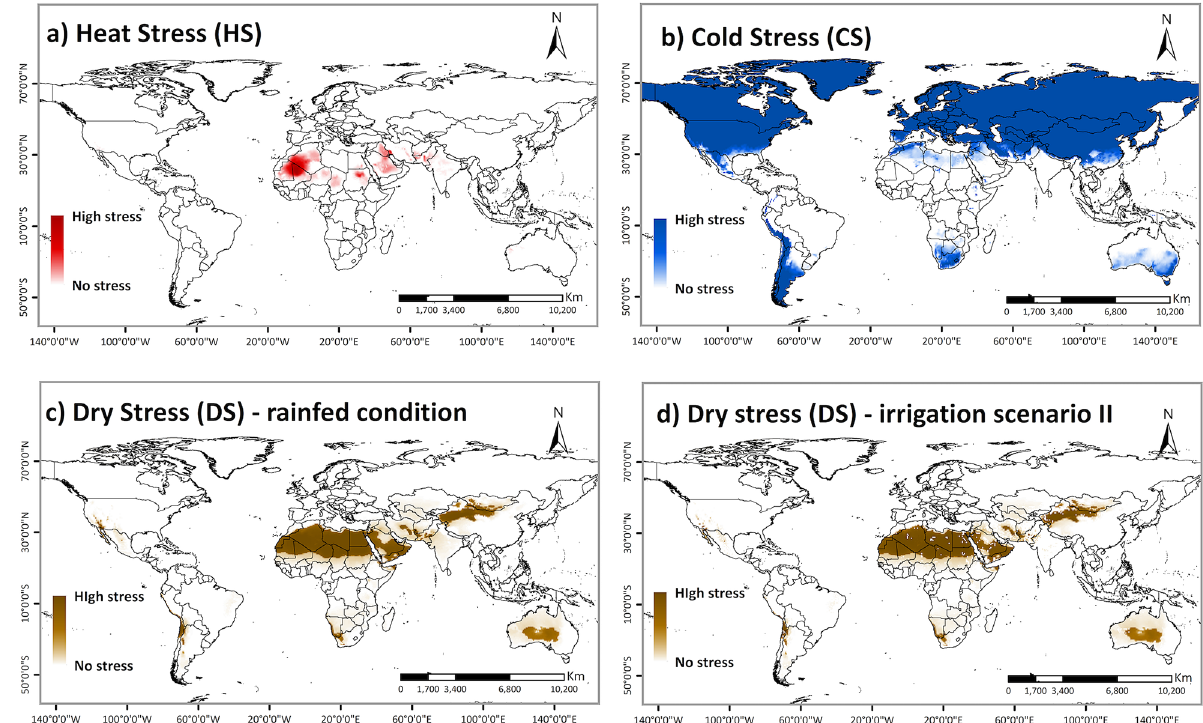
Figure 3. Abiotic stresses that limit FAW distribution and year-round establishment in the world. Areas with projected annual (a) heat stress, ( b ) cold stress, ( c ) dry stress (with rainfed condition), and ( d ) dry stress (with irrigation scenario II) that limit FAW population establishment under current climates. ArcMap 10.8 (https:// deskt op. arcgis. com/ en/